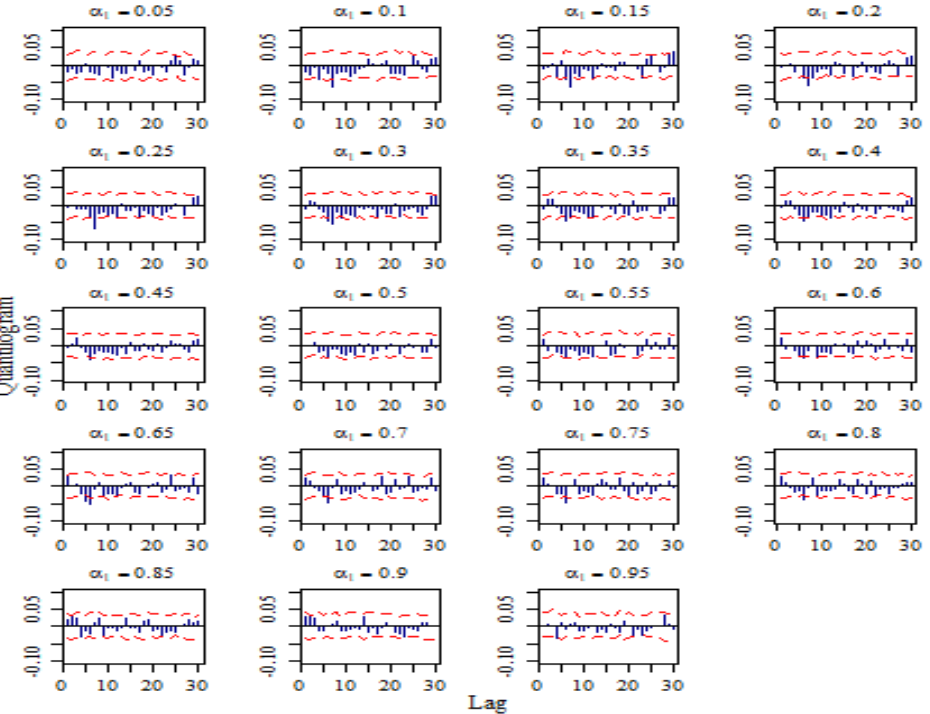
for 𝑞𝑞 2 ( 𝛼𝛼 2 ) 𝛼𝛼 2 =